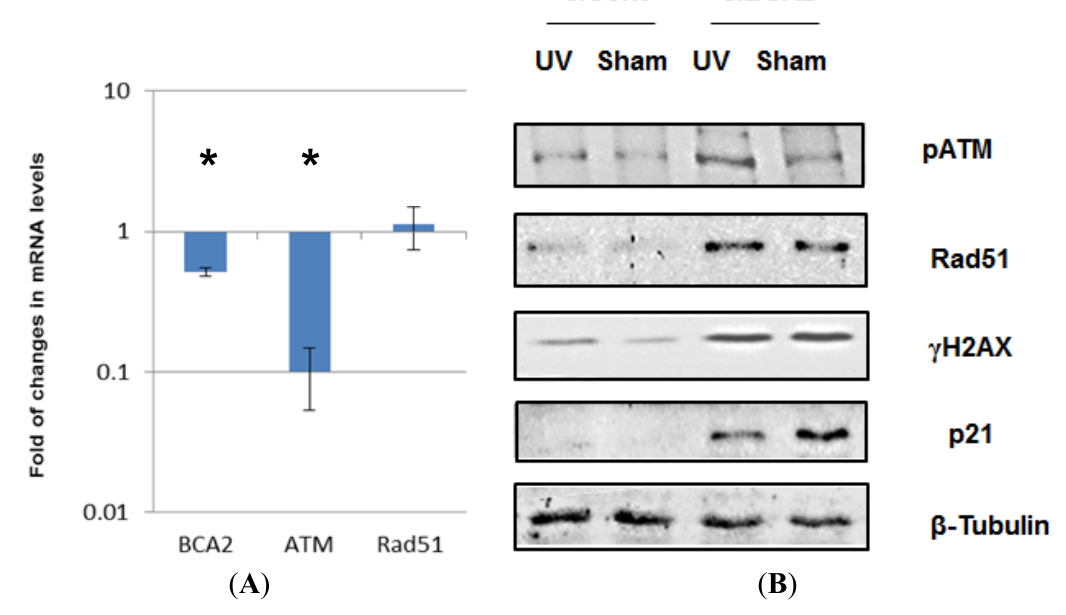
Figure 4. BCA2 knockdown up-regulated several DDR proteins. ( A ) Transcriptional levels of BCA2, ATM and Rad51 genes were analyzed with quantitative real-time PCR at 72 h post-transfection with scrambled or BCA2-targeted siRNAs; ( B ) Replicate cultures of MCF-7 cells were transfected with siRNA against BCA2 or non-targeting control siRNA prior to irradiation and post-irradiation incubation. At 2 h post-irradiation, cell extracts were isolated and analyzed by SDS-PAGE and immunoblotting with the indicated antibodies. * denotes significant difference between control siRNA- and BCA2 siRNA-treated groups with p <